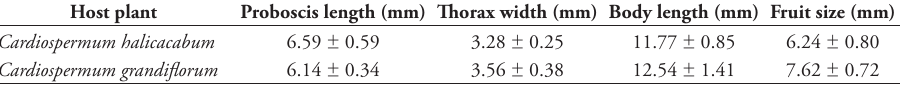
Table 2. Grand means ( ± SD) of proboscis length and body size measures (in mm) of soapberry bugs in KNP, and fruit sizes (in mm) of their Cardiospermum hosts.